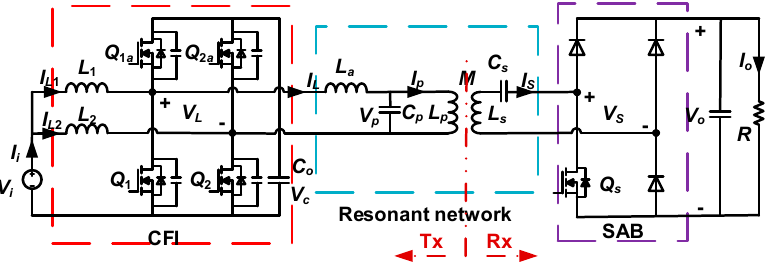
Figure 1. Proposed circuit diagram of WPT systems with one receiver.